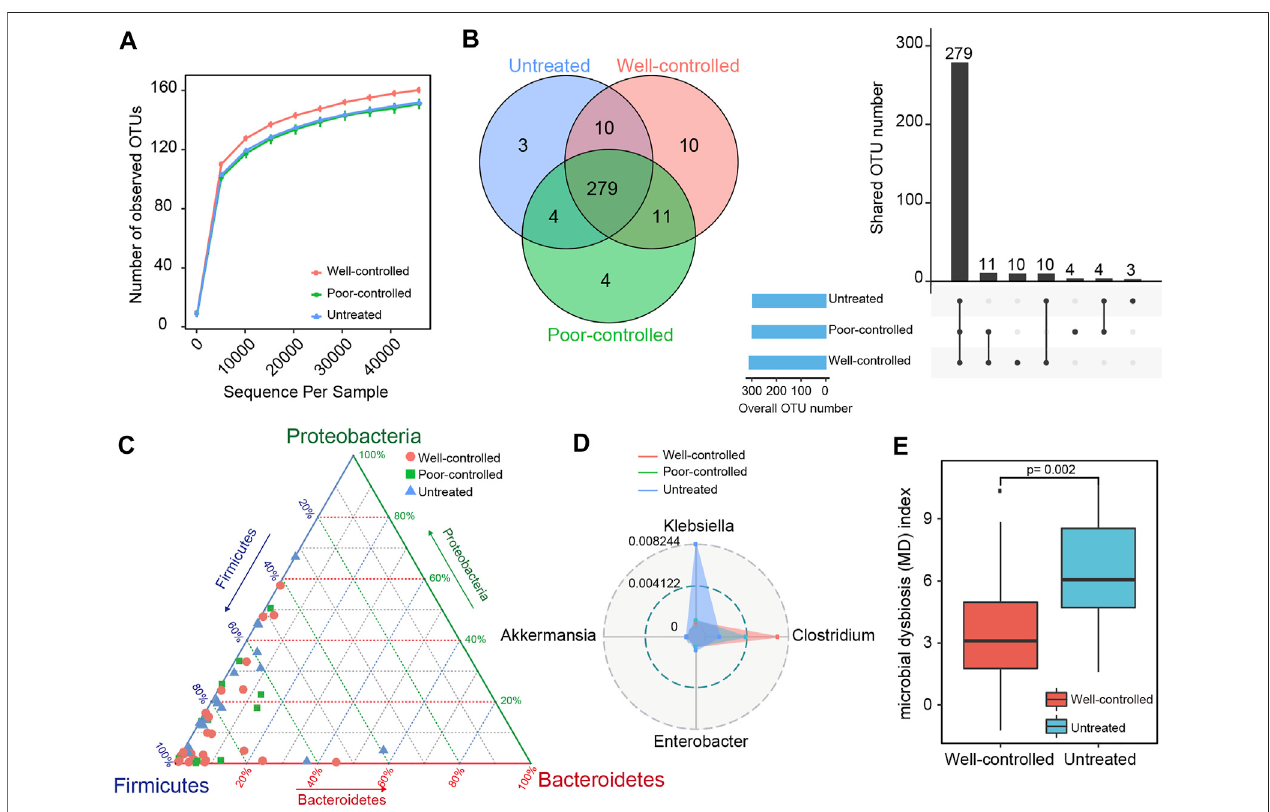
FIGURE 1 | Taxonomic distribution of fecal microbiome in ACEI/ARB well-controlled and poor-controlled HTN subjects. (A) A rarefaction curve in each group was obtainedbygraduallyexpandingthesequencingdepthofrandomsamples.Thecurvesapproachedsaturationasthesamplesequencingdepthadvancedandindicated that the sequencing data were suf fi cient and stable. (B) Venn diagrams and an upset view showing the number of OTUs shared or uniquely distributed in the untreated and treated patients (well-controlled or poor-controlled groups). The black bar charts represent the number of OTUs shared in the groups, while those at the bottomleftshowthenumberofOTUsineachgroup.Thedottedlineattherightbottomindicatesthesharepattern.Atotalof279OTUsweresharedamonggroups. (C) Thedistributionofhypertensivesubjectsingroupsisplottedintoaternarydiagrambasedontherelativeabundanceofthethreemostdominanttaxonatthephylumlevel: Proteobacteria, Firmicutes,andBacteroidetes. (D) Radarchartsforthedistincttaxonomicalcompositionofgroupsinthetopfourmostabundantgenera.Theinnerblue circle represents a relative abundance at 0.004122 and the outer gray circle represents a relative abundance of 0.008244. The untreated group was more predominant with Klebsiella, while the ACEI/ARB-treated groups were more enriched with Clostridium. (E) Box plots showing the gut MD index in untreated and well-controlled hypertensive patients. Theboxesrepresenttheinterquartileranges, the insidelinerepresentsthemedian, and thecircles represent outliers.The MDindex issigni fi cantly depressed in the well-controlled group as compared with the untreated ones; p = 0.002; Wilcoxon rank-sum test.